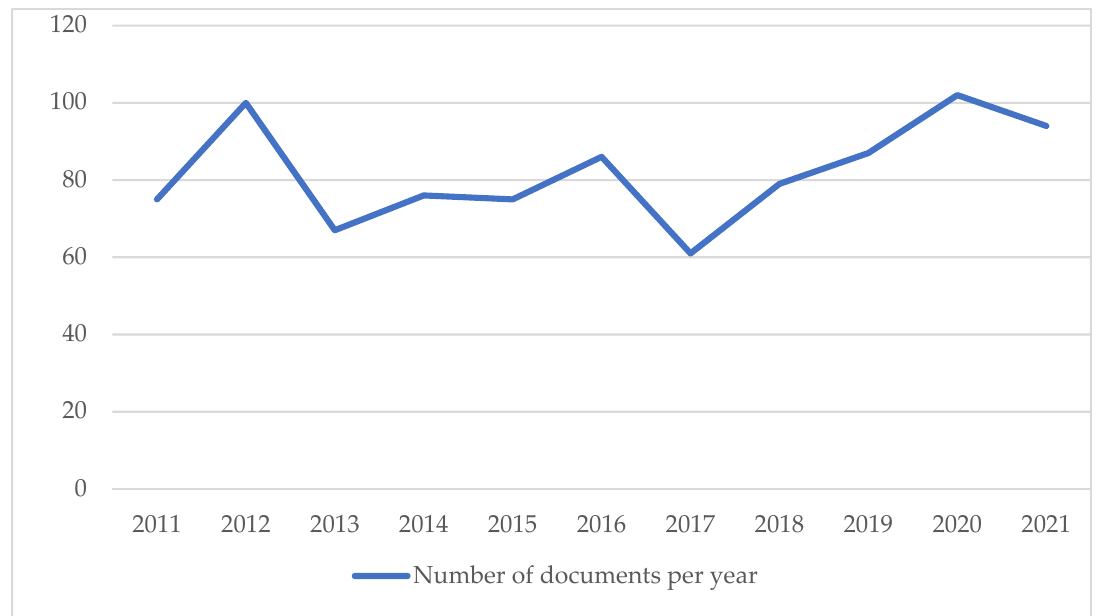
Figure 1. Annual distribution of published articles.